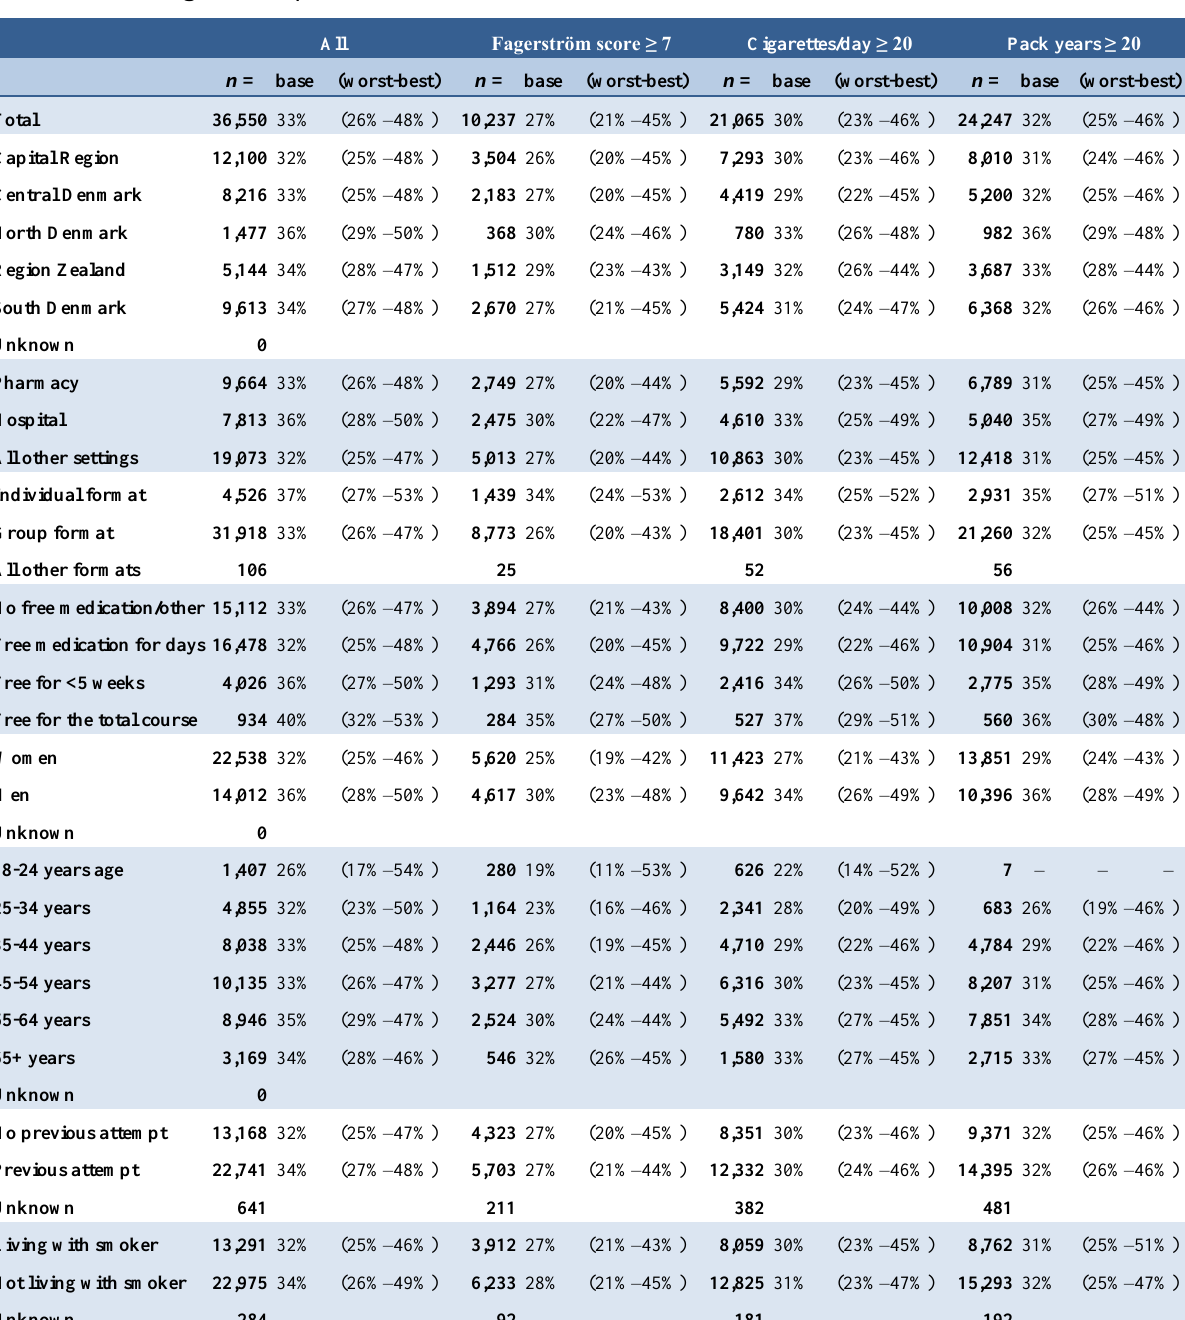
Table 1. Characteristics of the study population allover and by heavy smoking definition a , with continuous abstinence rates for the group of patients responding to follow up (base) and under two scenarios: (1) assuming non-responders relapsed (worst case),